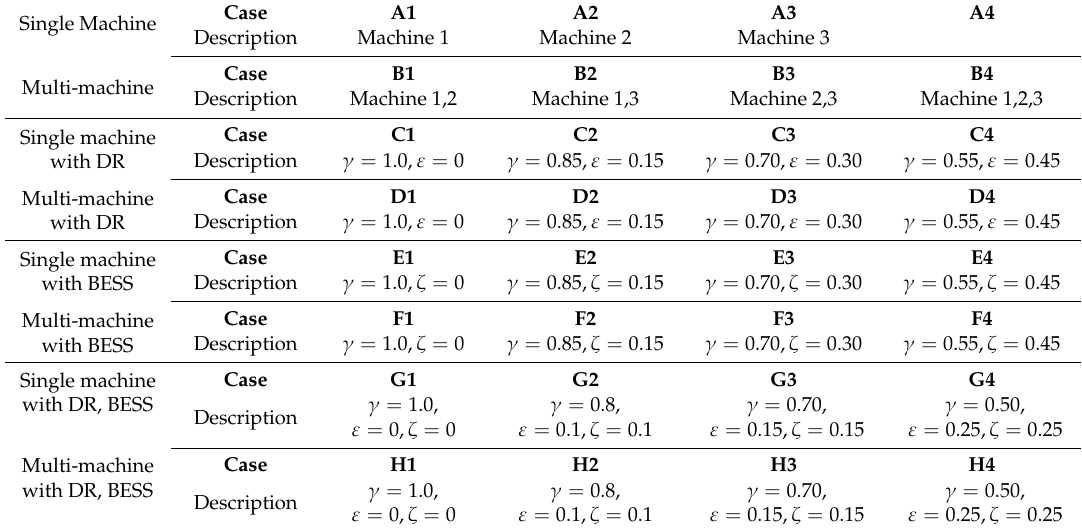
Table 2. Description of simulation